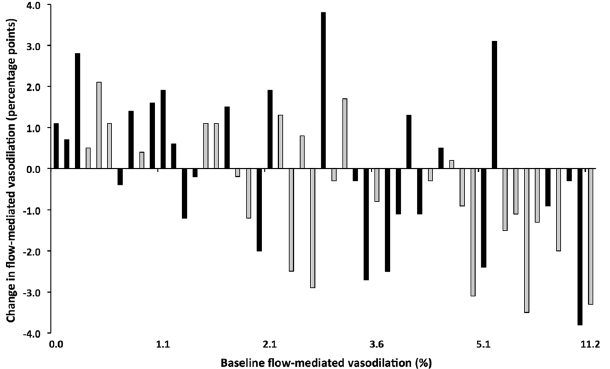
Figure 1. Individual changes in flow-mediated vasodilation. Effects of 24-week magnesium (black) and placebo supplementation (grey) on brachial artery flow-mediated vasodilation in overweight and obese middle-aged and elderly